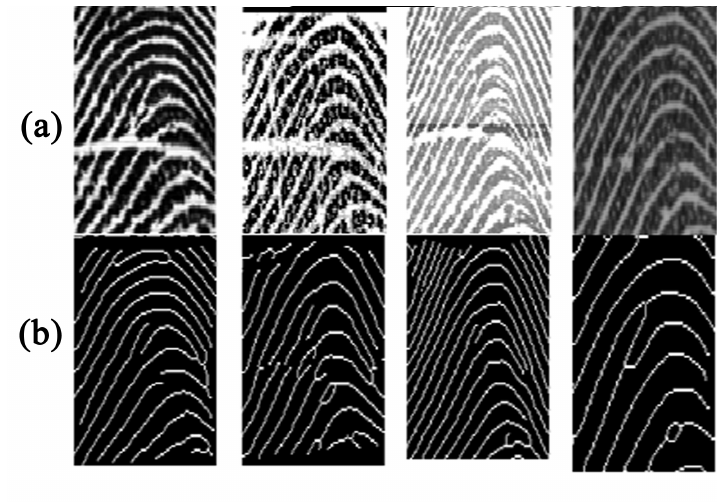
Figure 5. ( a ) Magnified views of fingerprints from the same finger captured with different sensors; ( b ) the corresponding thinned images.